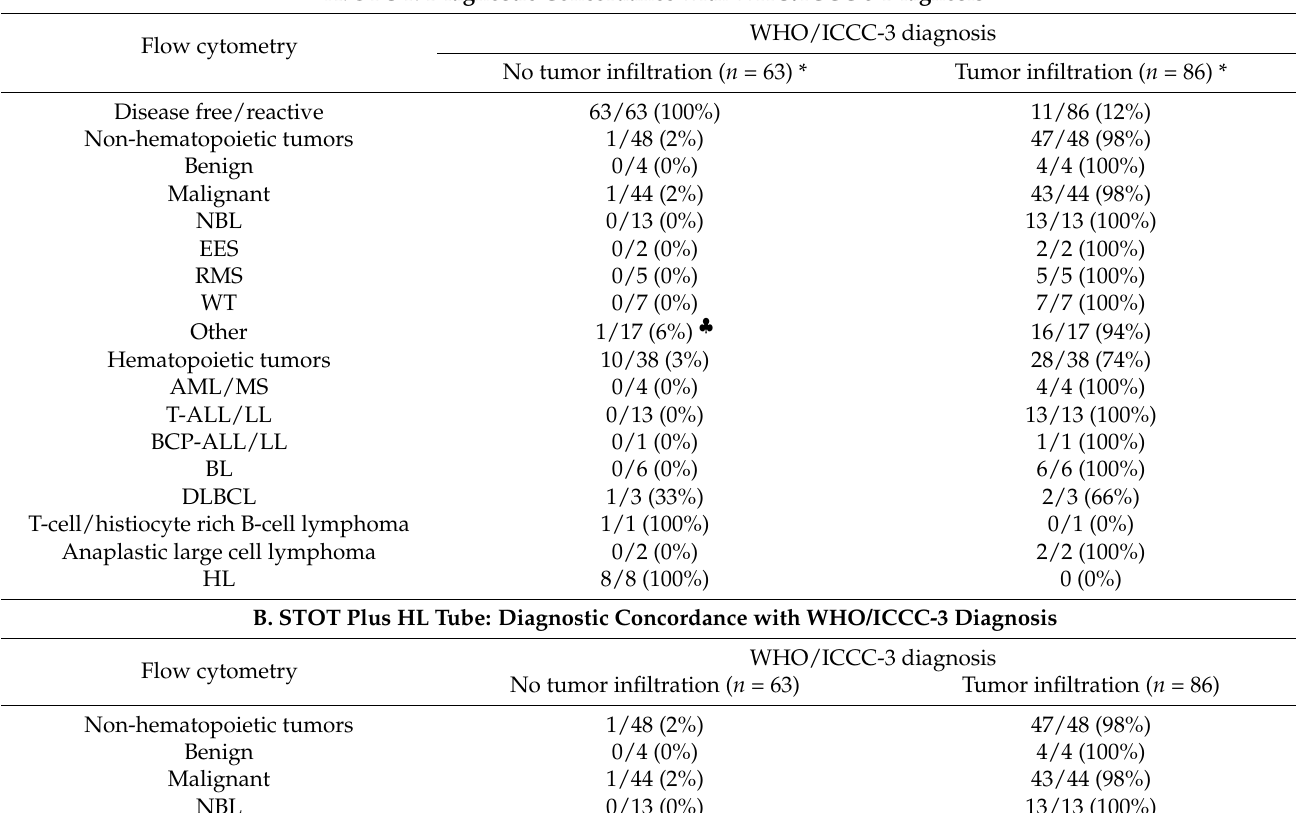
Table 3. Validation of STOT alone ( A ) or together with the HL tube ( B ) for the diagnostic screening, orientation, and classification of non-hematopoietic and hematopoietic (solid) tumors: comparison with the conventional WHO/ICCC-3 diagnosis. A. STOT: Diagnostic Concordance with WHO/ICCC-3 Diagnosis Flow